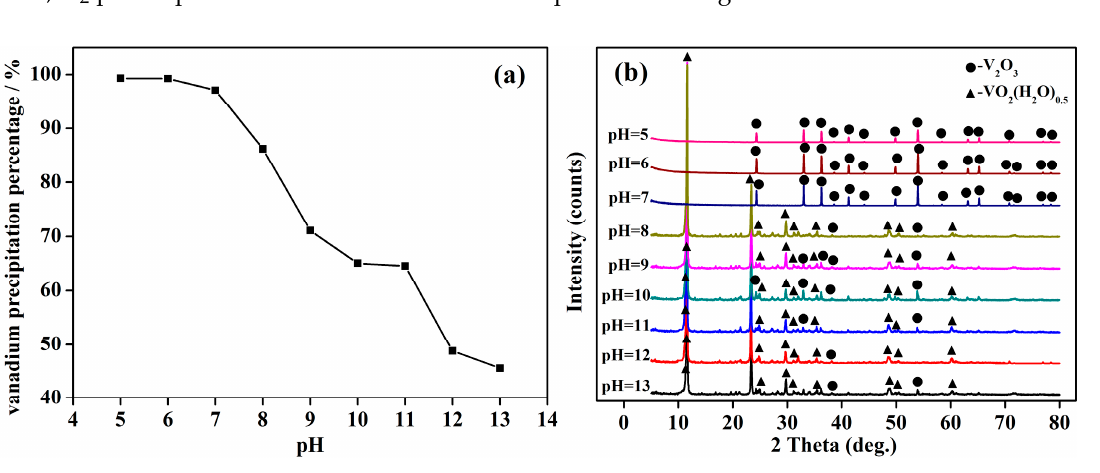
Figure 4. ( a ) Effect of initial solution pH on the vanadium precipitation percentage; ( b ) XRD patterns of the precipitates obtained at different initial solution pH.